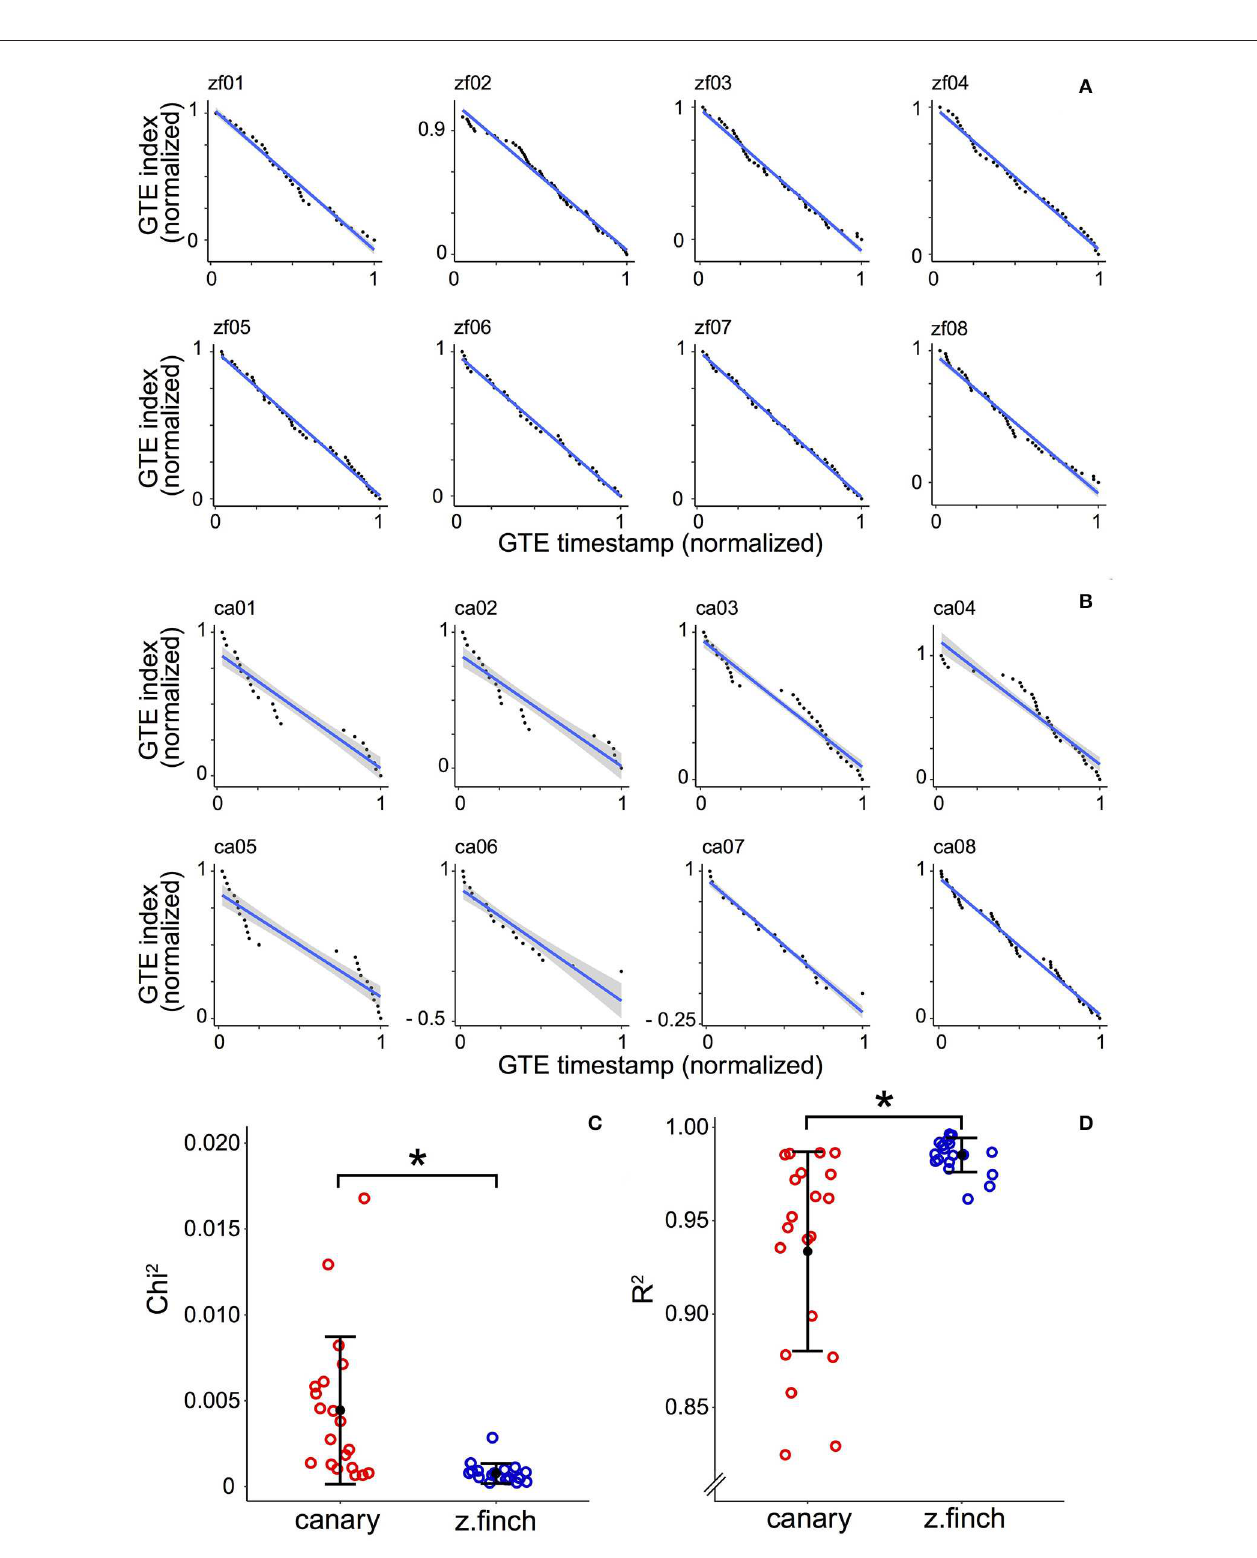
FIGURE 2 | Normalized Gesture Trajectory Extrema (GTE) position plots for zebra finches and canaries. (A) Normalized GTE position plots for eight zebra finch motifs selected at random. The GTE timestamps in the motif and the GTE indices are normalized. The blue line shows the best fit using ordinary least squares. The gray